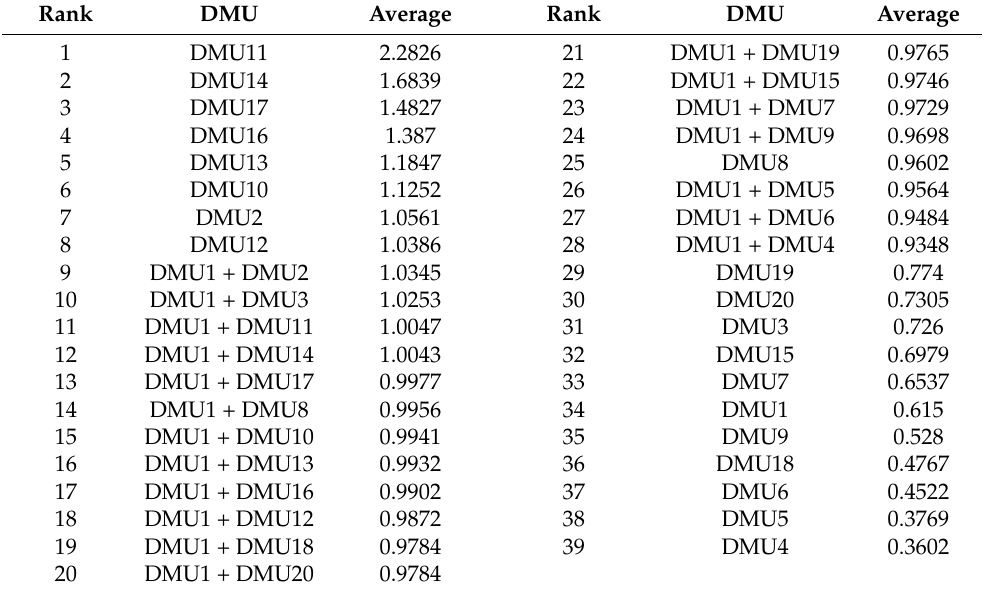
Table 10. Efficiency and ranking after strategic